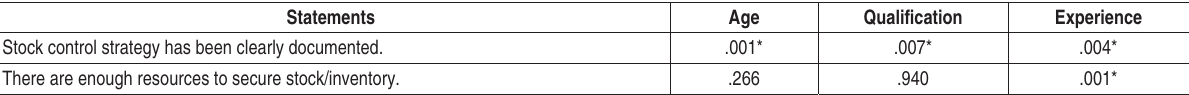
Table 6. The results of the Chi square